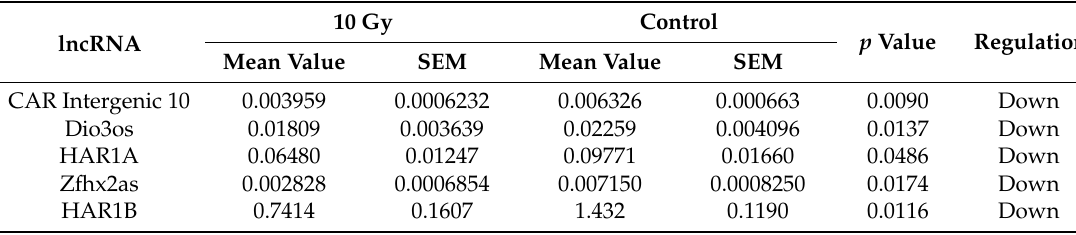
Table 3. Expression values of CAR Intergenic 10, Dio3os, HAR1A, Zfhx2as, and HAR1B after exposure to 10 Gy